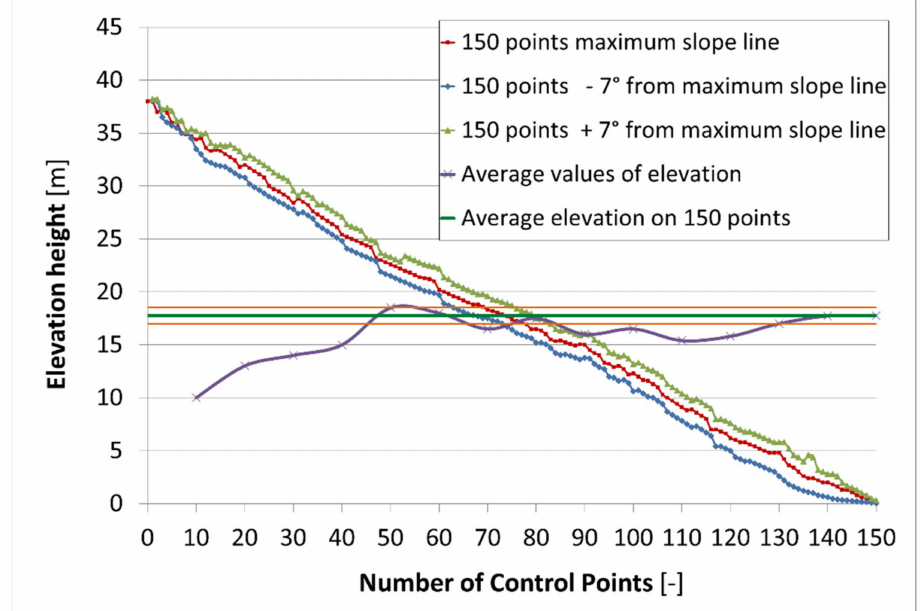
Figure 7. Average values of elevation heights in alluvial fan area No. 7.